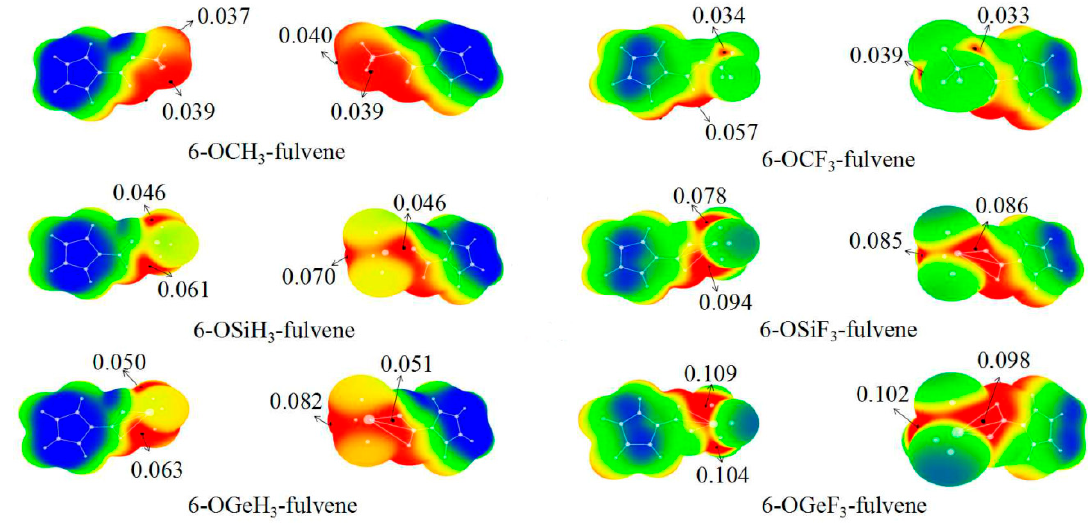
Figure 1. MEP maps of 6-OTX 3 -fulvene on the 0.001 electrons bohr − 3 isosurface. Color ranges, in au, are: red, >0.03; yellow, 0.03–0.02; green, 0.02–0.00; blue, <0.